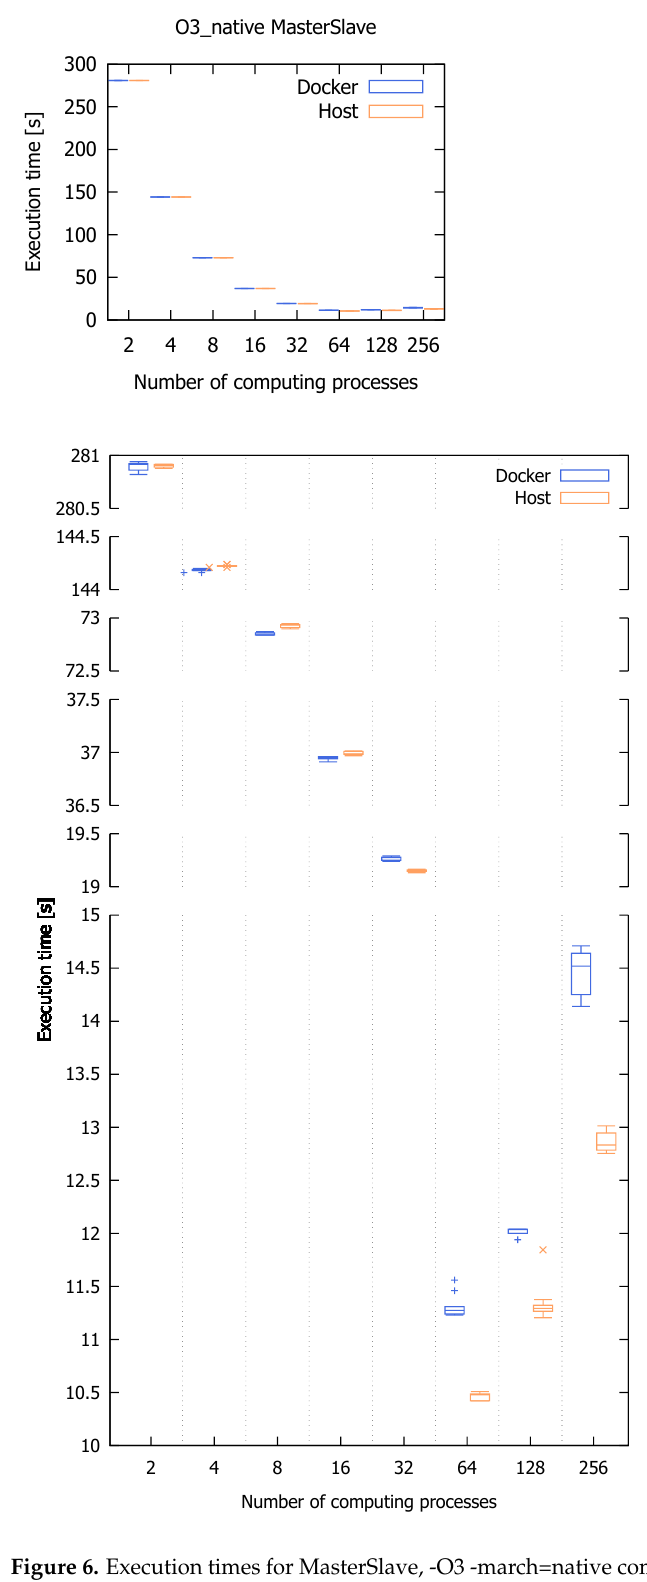
Figure 6. Execution times for MasterSlave, -O3 -march=native compilation flag; boxplot notation: me- dians, Q1 and Q3, max(Q1 − 1.5IQR, minimum) and min(Q3+1.5IQR, maximum) as well as potential outliers (+ for Docker, x for